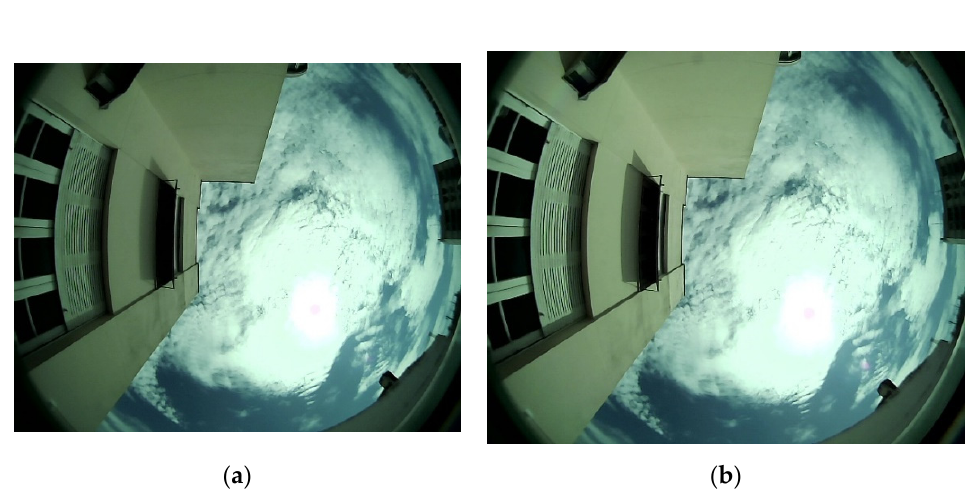
Figure 5. Raw image examples from the beginning of an event ( a ) and from the end ( b ).